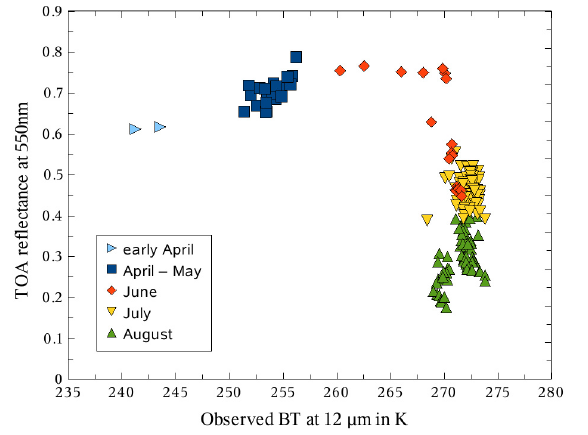
Fig. 8. Analysis of the validation dataset for station OPAL which contains nearly 200 points spring and summer of years 2007–2009. Only cloud free snow flagged data were taken into account. The dependence of TOA reflectance at 550nm on BT at 12µm shows the evolution of surface type with the time of the year. Most of the dataset represents melting sea ice surface type (summer months), whereas data from April and May represent ice covered with snow.